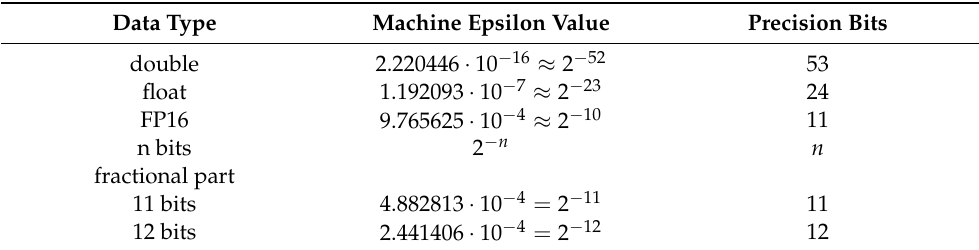
Table 8. Machine epsilon values for the different floating point numbers, for a general integer number of n bits in the fractional part, and also for the integer arithmetic of results shown in Table